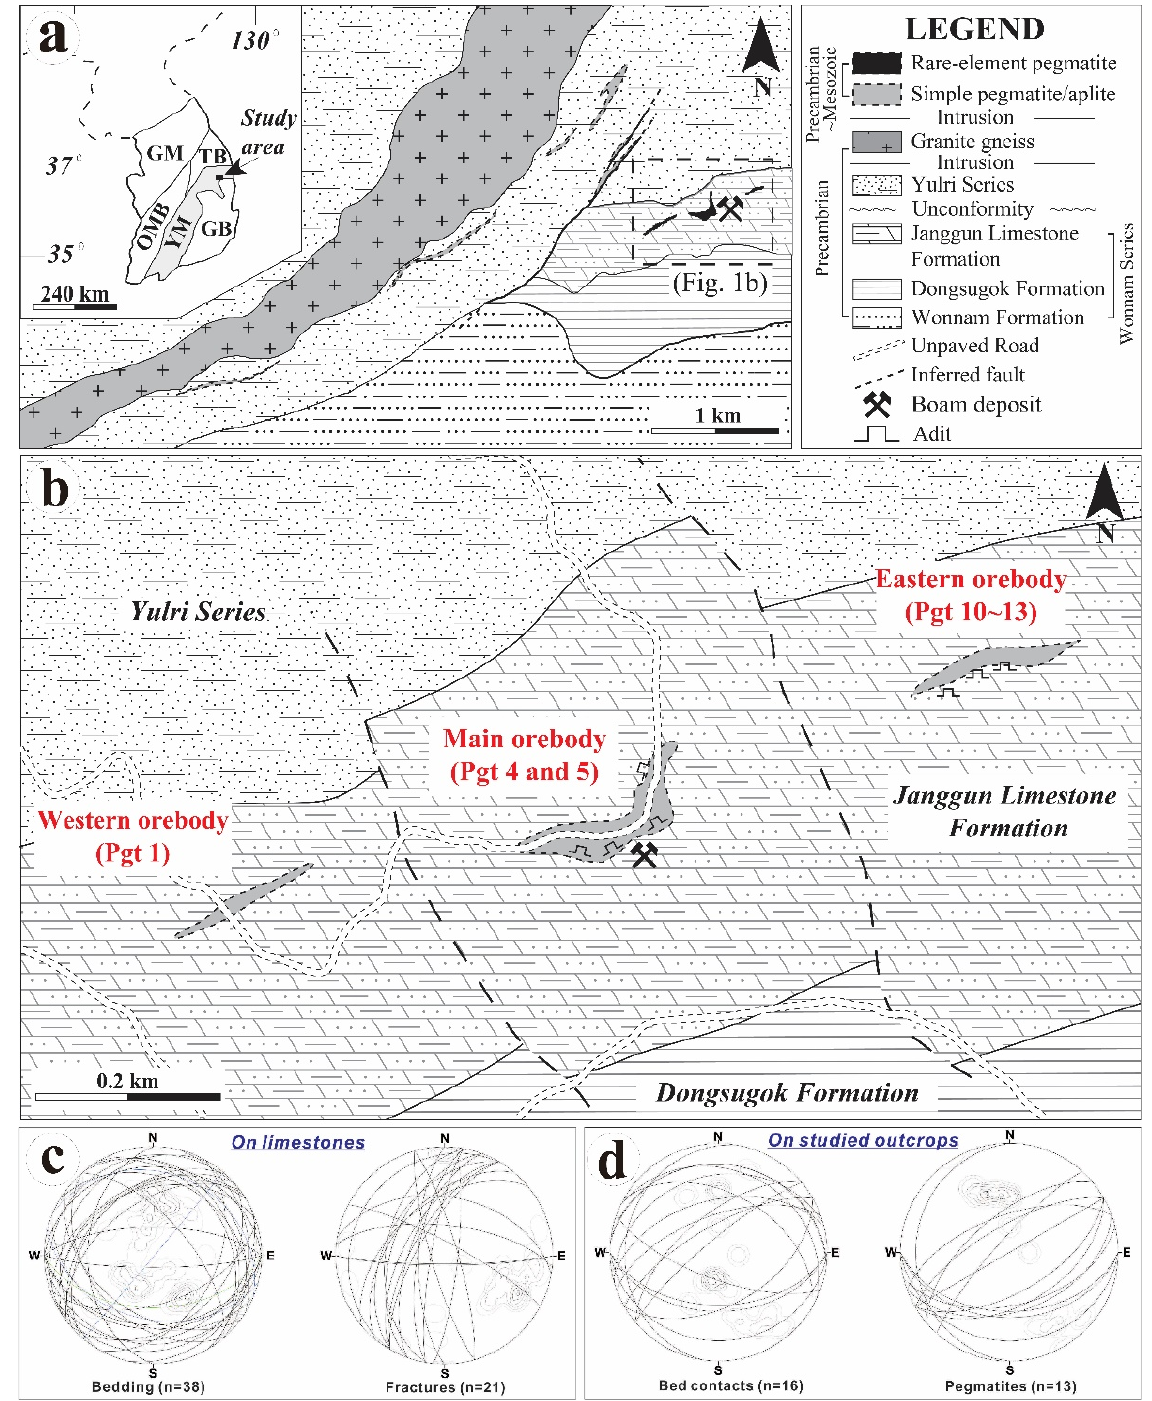
Figure 1. ( a ) Simplified tectonic map of the southern Korean Peninsula and geological map of Uljin, South Korea (modified from [15]). ( b ) Geological map of the Boam deposit showing the location of the studied pegmatites (modified from [5]). ( c ) The stereo ‐ nets (equal area, lower hemisphere) show dominant directions of bedding and fractures in Janggun Limestone Formation. ( d ) The stereo ‐ nets (equal area, lower hemisphere) show dominant directions of bedding and pegmatites in the studied outcrops.